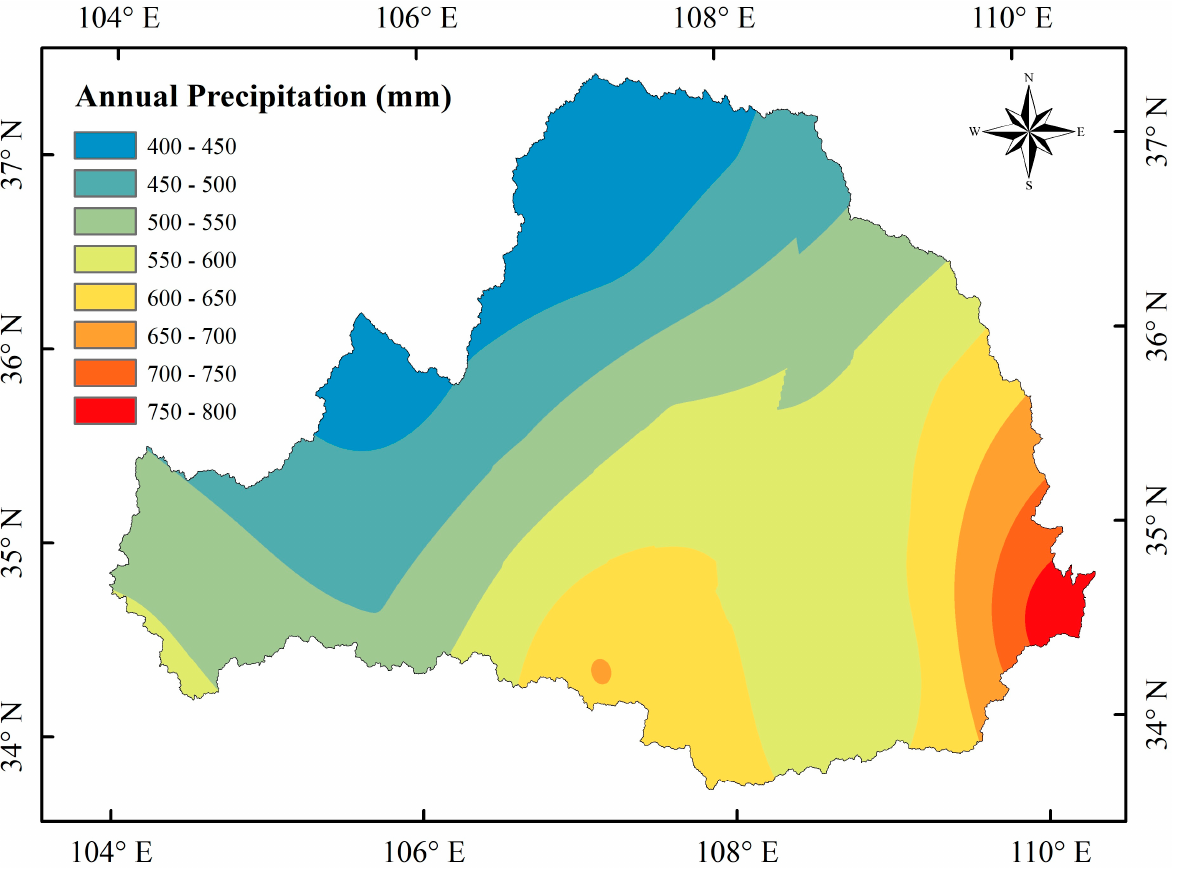
Figure 8. Spatial distribution of average precipitation from 1960–2018 in Weihe River Basin.